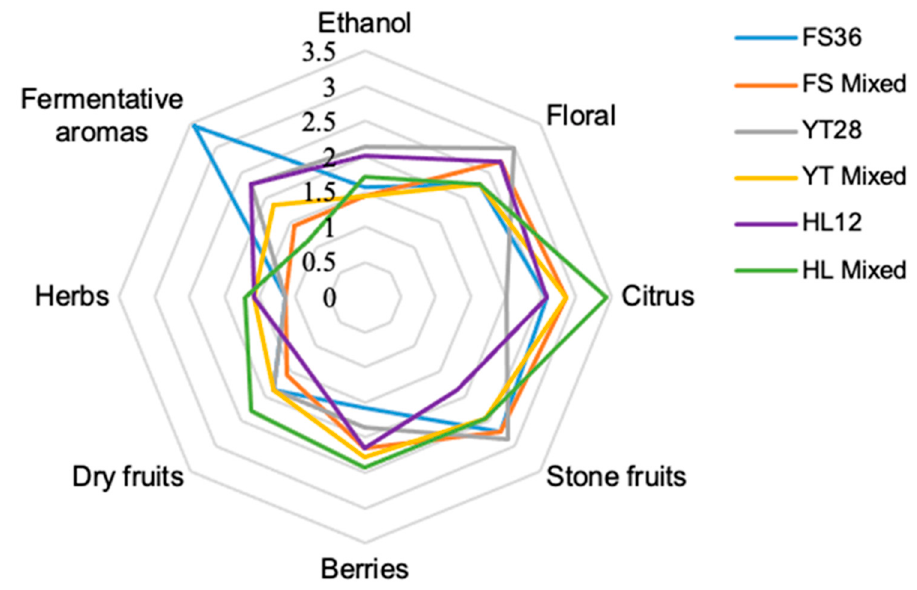
Figure 4. Radar plots of sensory evaluation of six Marselan wines.